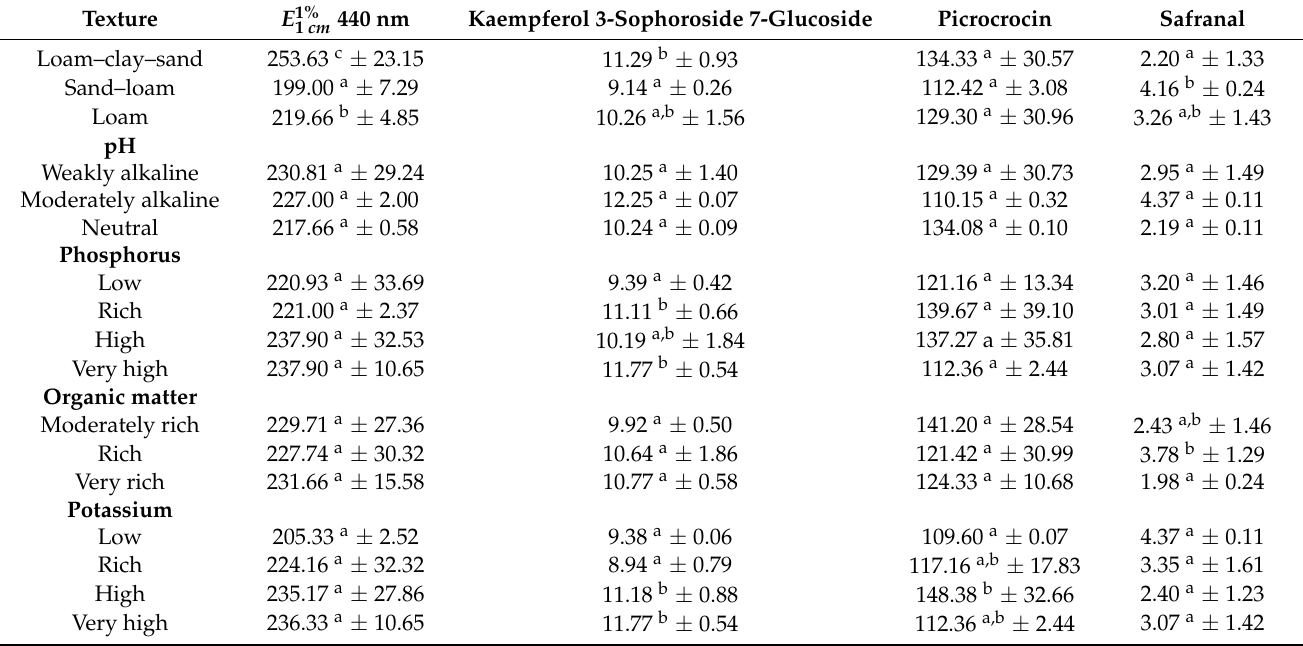
Table 3. Effect of soil texture, pH, mineral elements and organic matter on coloring strength, kaempferol 3-sophoroside 7-glucoside, picrocrocin and safranal (g kg − 1 of dry matter) of Moroccan